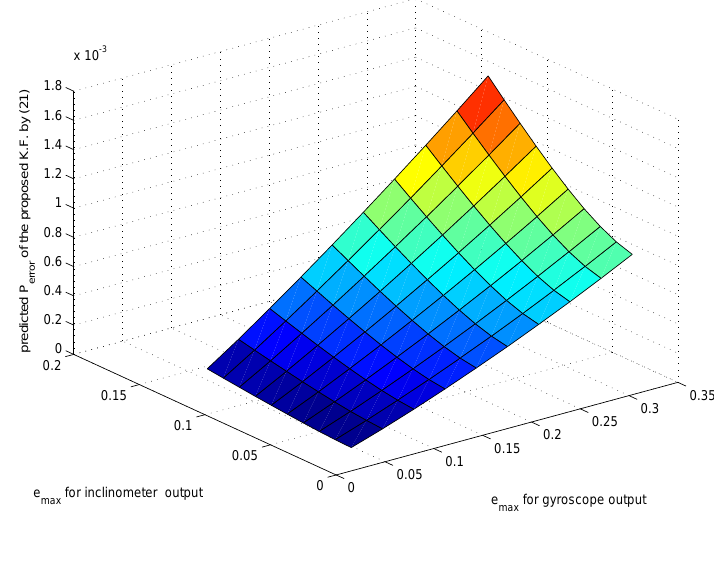
√ ∑ ( θ ( k ) ¡ ˆ θ ( k )) 2 ) of the proposed